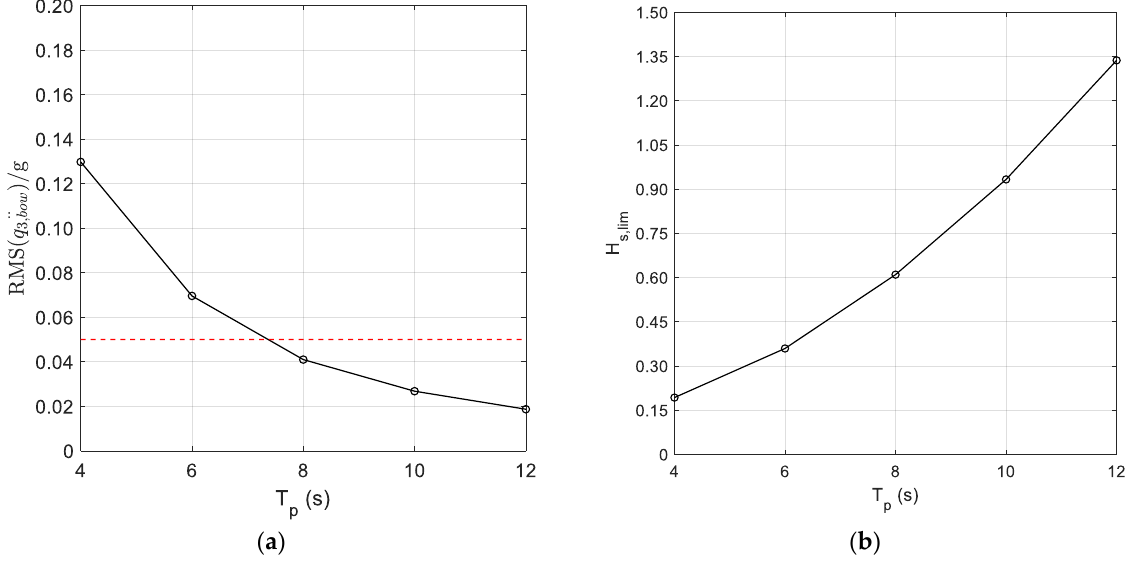
Figure 7. Main parameters of selected configurations as a function of vessel speed: ( a ) RMS of vertical acceleration at the bow, ( b ) maximum allowable significant wave height.